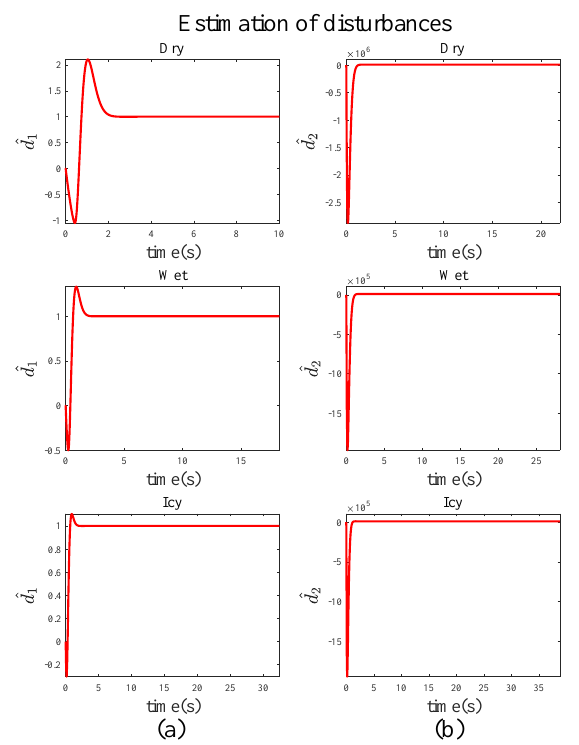
Figure 10. Simulation results for the estimation of matched and unmatched perturbations, where (a) and (b) represent estimations of d 1 and d 2 , respectively.